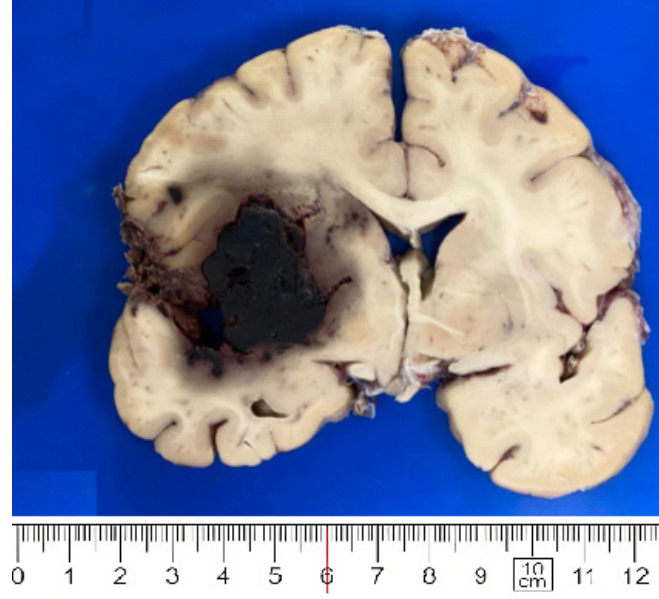
Figure 1. Large hemorrhage in basal ganglia (case